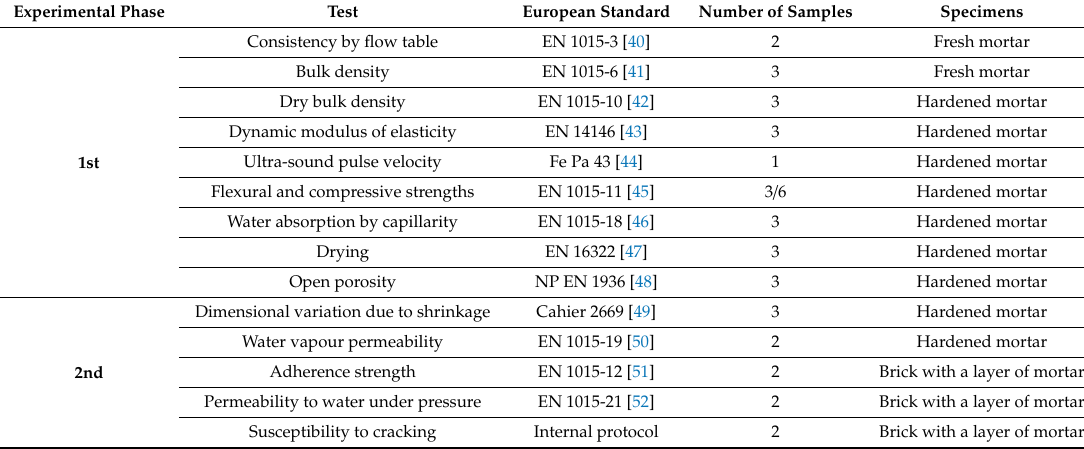
Table 5. Composition of the mortar mixes (kg / m 3